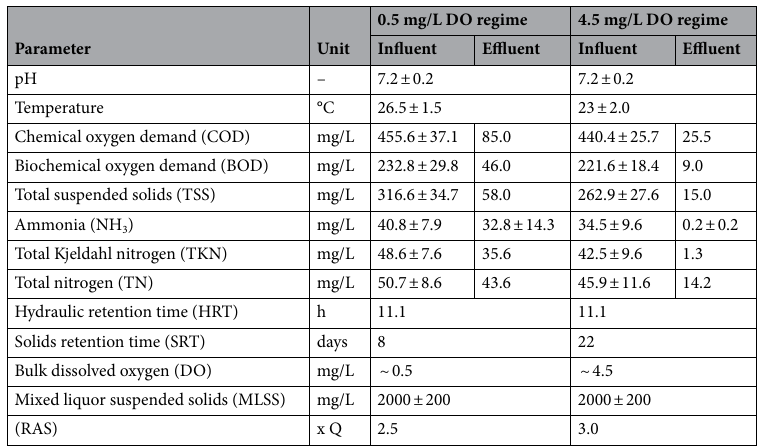
Table 2. Influent, effluent and operational characteristics of HySAF pilot plant in Rishikesh, India used for validation. Value range provided where present in literature 51